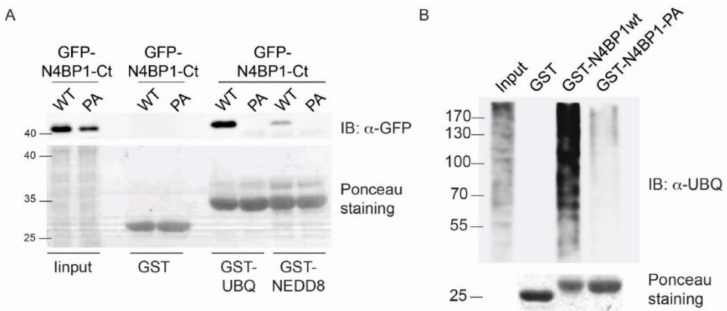
Figure 2. A Pro-Phe motif in N4BP1 is involved in the interaction with ubiquitin and ubiquitinated proteins. ( A ) The amino acid fragment spanning residues 813–896 of N4BP1 and the Pro866Ala mutant (PA) were expressed as GFP fusions in HEK293 cells. Twenty hours post-transfection, cells were harvested, and lysates were incubated with glutathione S-transferase (GST)-ubiquitin, GST-NEDD8, or GST alone. Samples were analyzed by sodium dodecyl sulfate polyacrylamide gel electrophoresis (SDS-PAGE) with anti-GFP antibody. ( B ) Cell extracts from HEK293 cells were incubated with the GST fusions of N4BP1 (813–896aa), N4BP1-PA, or with the GST alone. Samples were analyzed by SDS-PAGE with ubiquitin antibody. Ponceau staining confirmed that equal amounts of purified proteins were